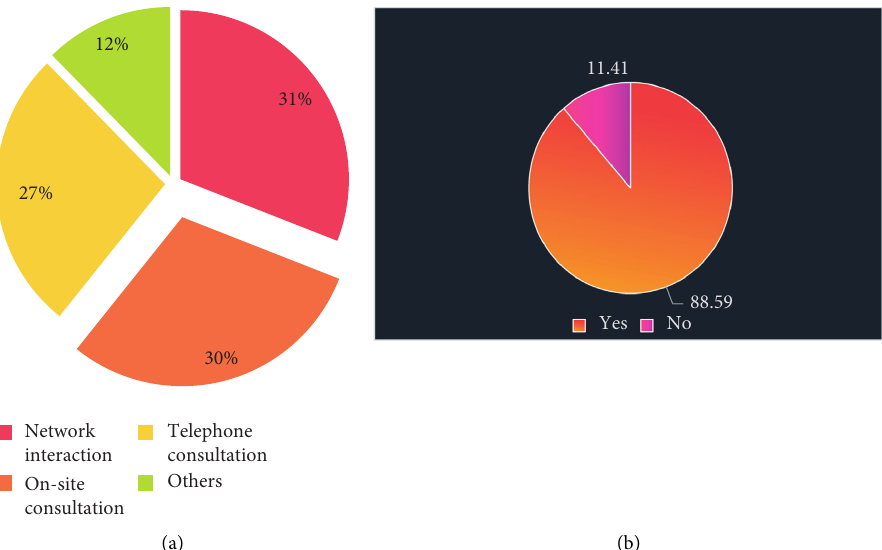
Figure 6: (a) Ranking of tourists’ preference for consulting services and (b) investigation of tourists’ mood sharing